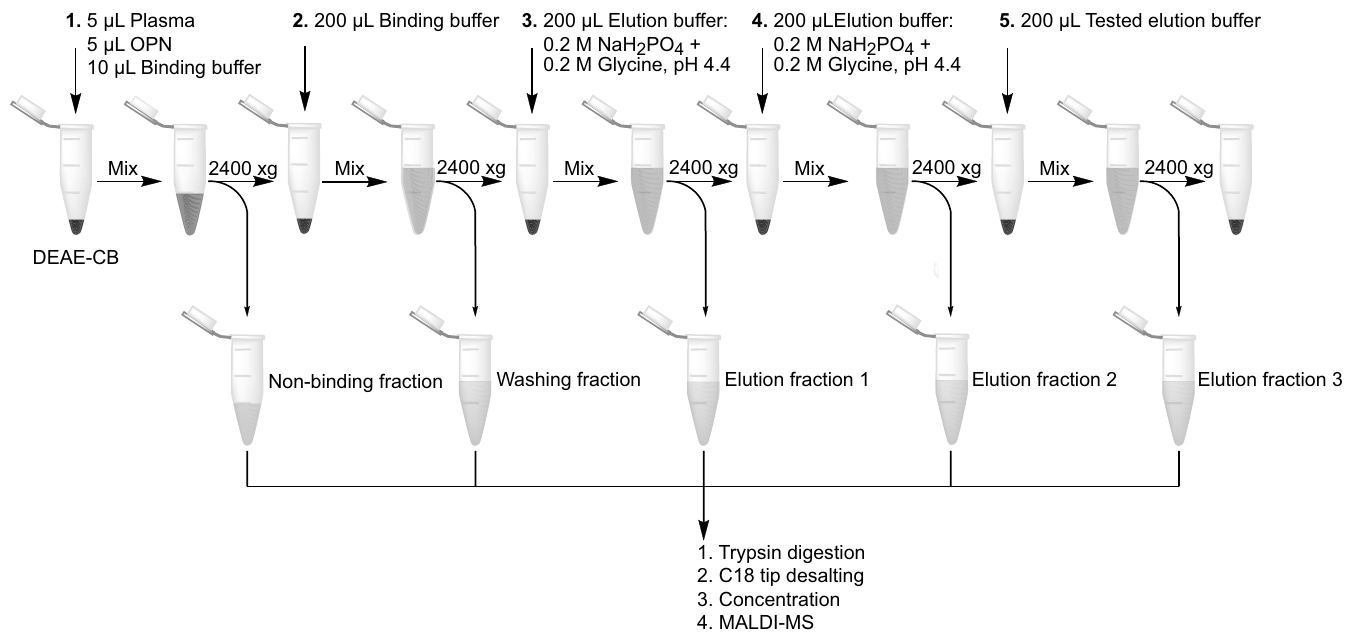
Fig 1. Schematics of the enrichment method for rhOPN in plasma samples (sample and buffer volumes were doubled for 1 μ g/ml rhOPN in plasma samples).